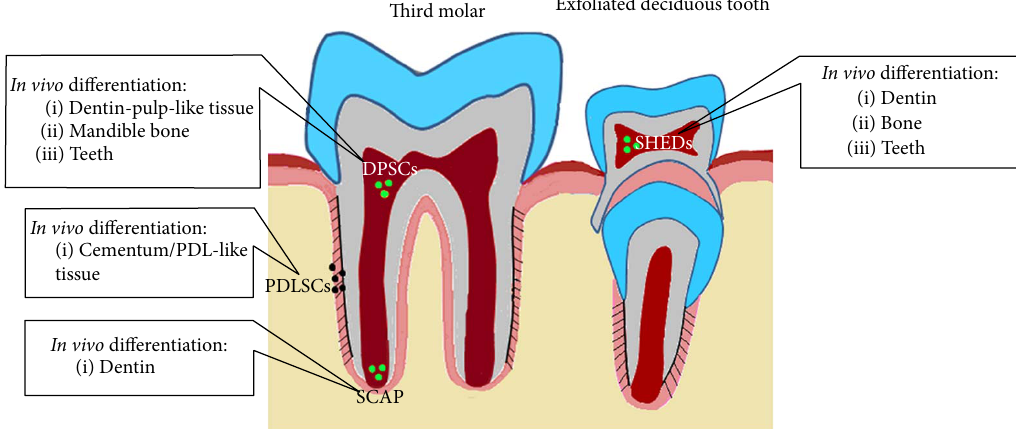
Figure 1: Schematic representation of the main stem cell sources in the human teeth and their differentiation potential in vivo . DPSCs: dental pulp stem cells, SHEDs: stem cells from human exfoliated deciduous teeth, PDLSCs: periodontal ligament stem cells, and SCAP: stem cells from the apical part of the